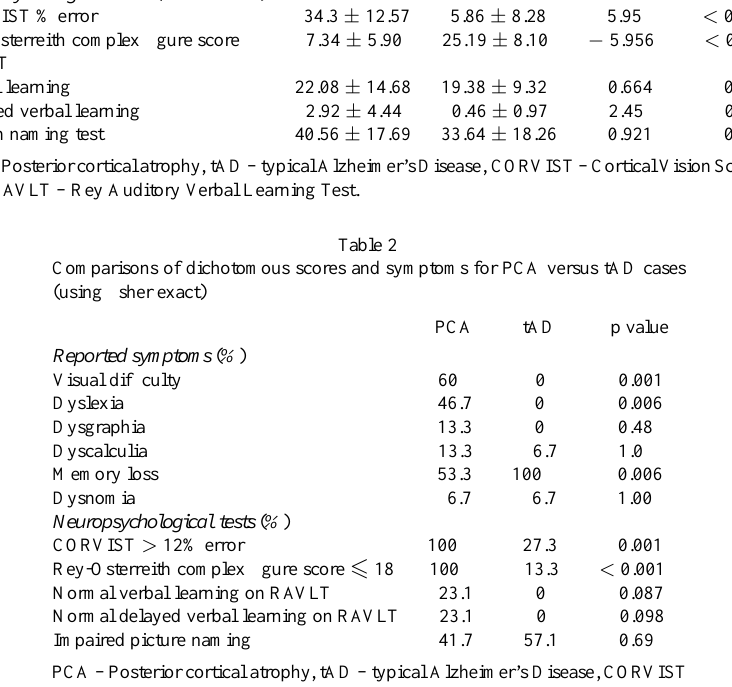
Table 1 PCA tAD